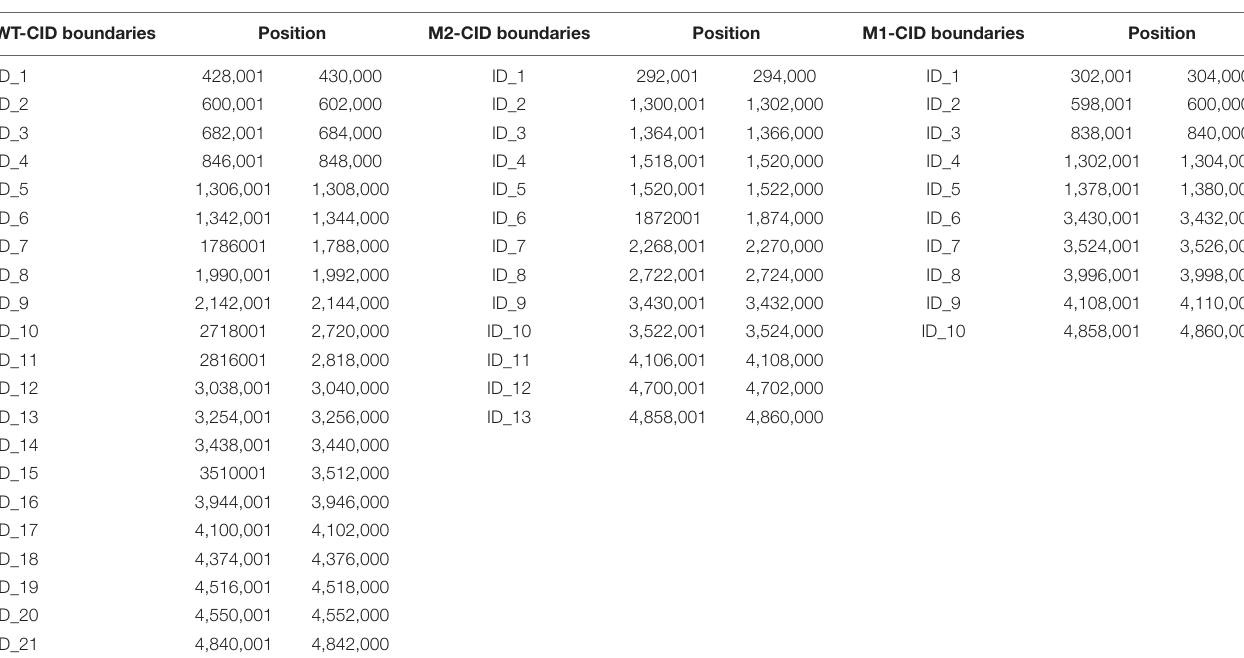
FIGURE 2 | Chromosome interaction structures. (A) Chromosome A/B compartments. The x-axis represents genomic coordinates. The y-axis represents the eigenvector values, with positive values in red representing compartment (A) , and negative values in black representing compartment (B) . (B) Chromosomal interaction domains. The x-axis represents genomic coordinates and y-axis represents the insulation index. Green lines indicate CIDs boundaries. TABLE 1 | Boundaries location of